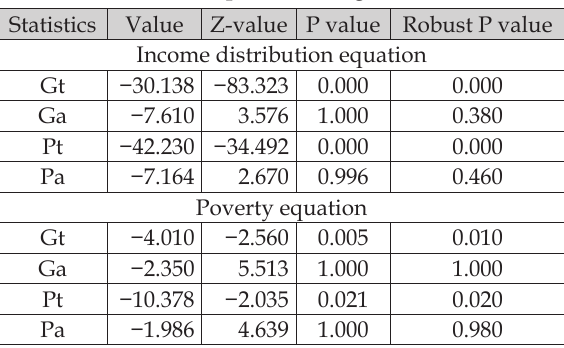
Table 7. Westerlund panel cointegration test